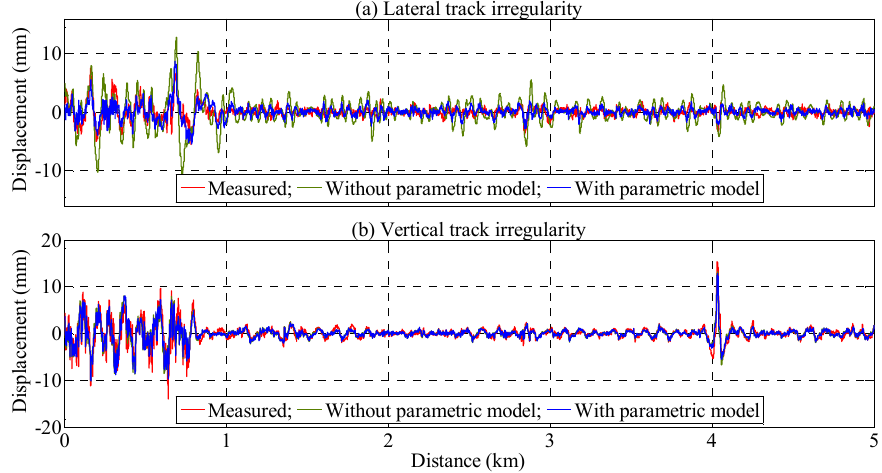
Figure 9. Estimation of track irregularities from the TGIS in the spatial domain.